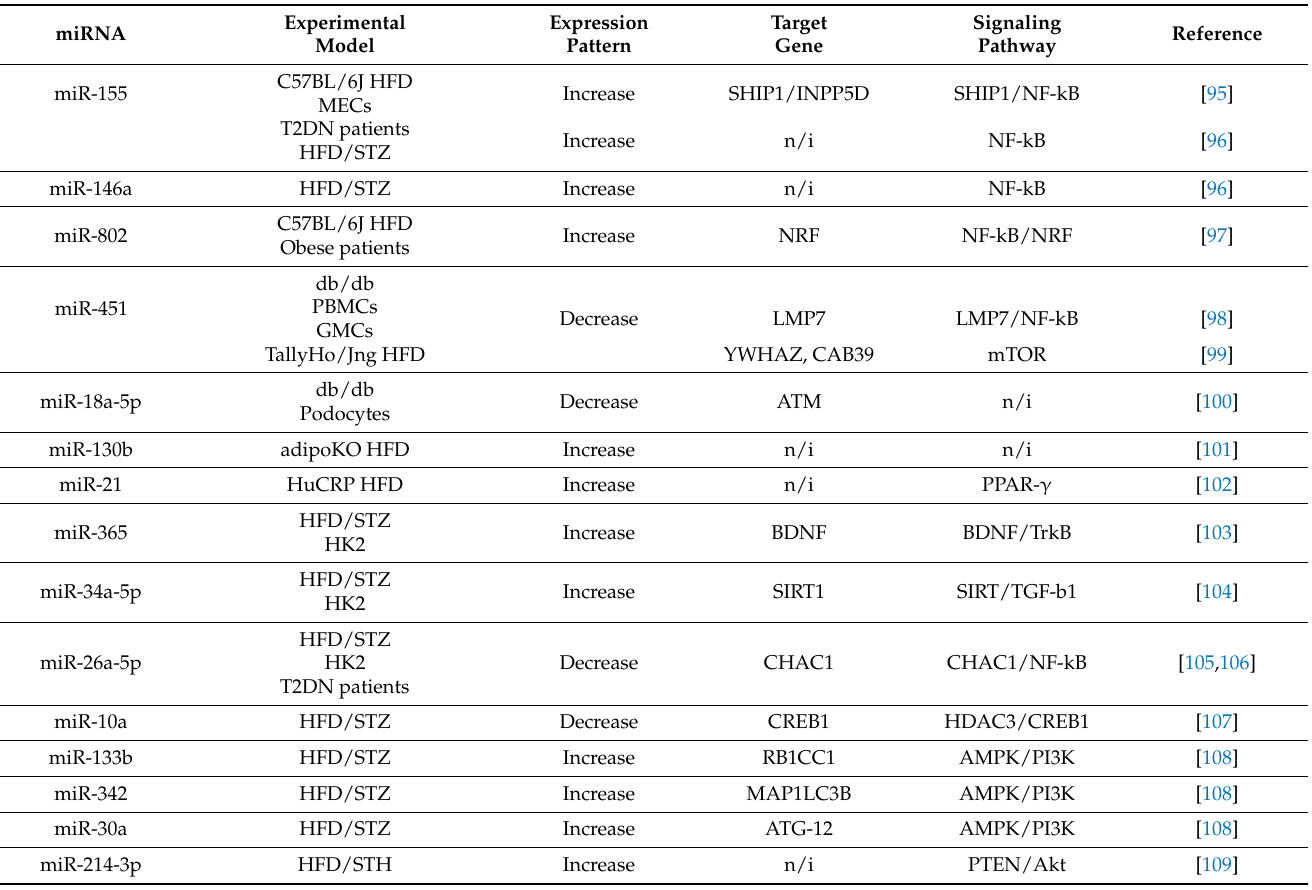
Table 1. miRNAs involved in obesity-associated